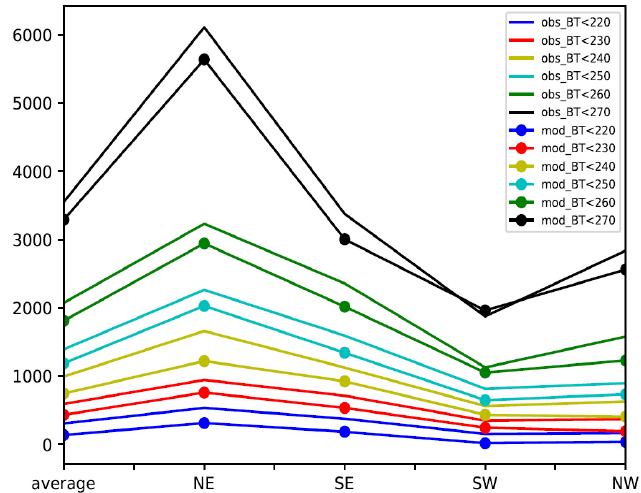
Figure 10. The number of pixels in the observed and model synthetic GOES-R IR BT images that are less than the certain thresholds (220 K, 230 K, 240 K, 250 K, 260 K and 270 K) in the 4 quadrants of NE SE SW and NW and the direction-averaged number.